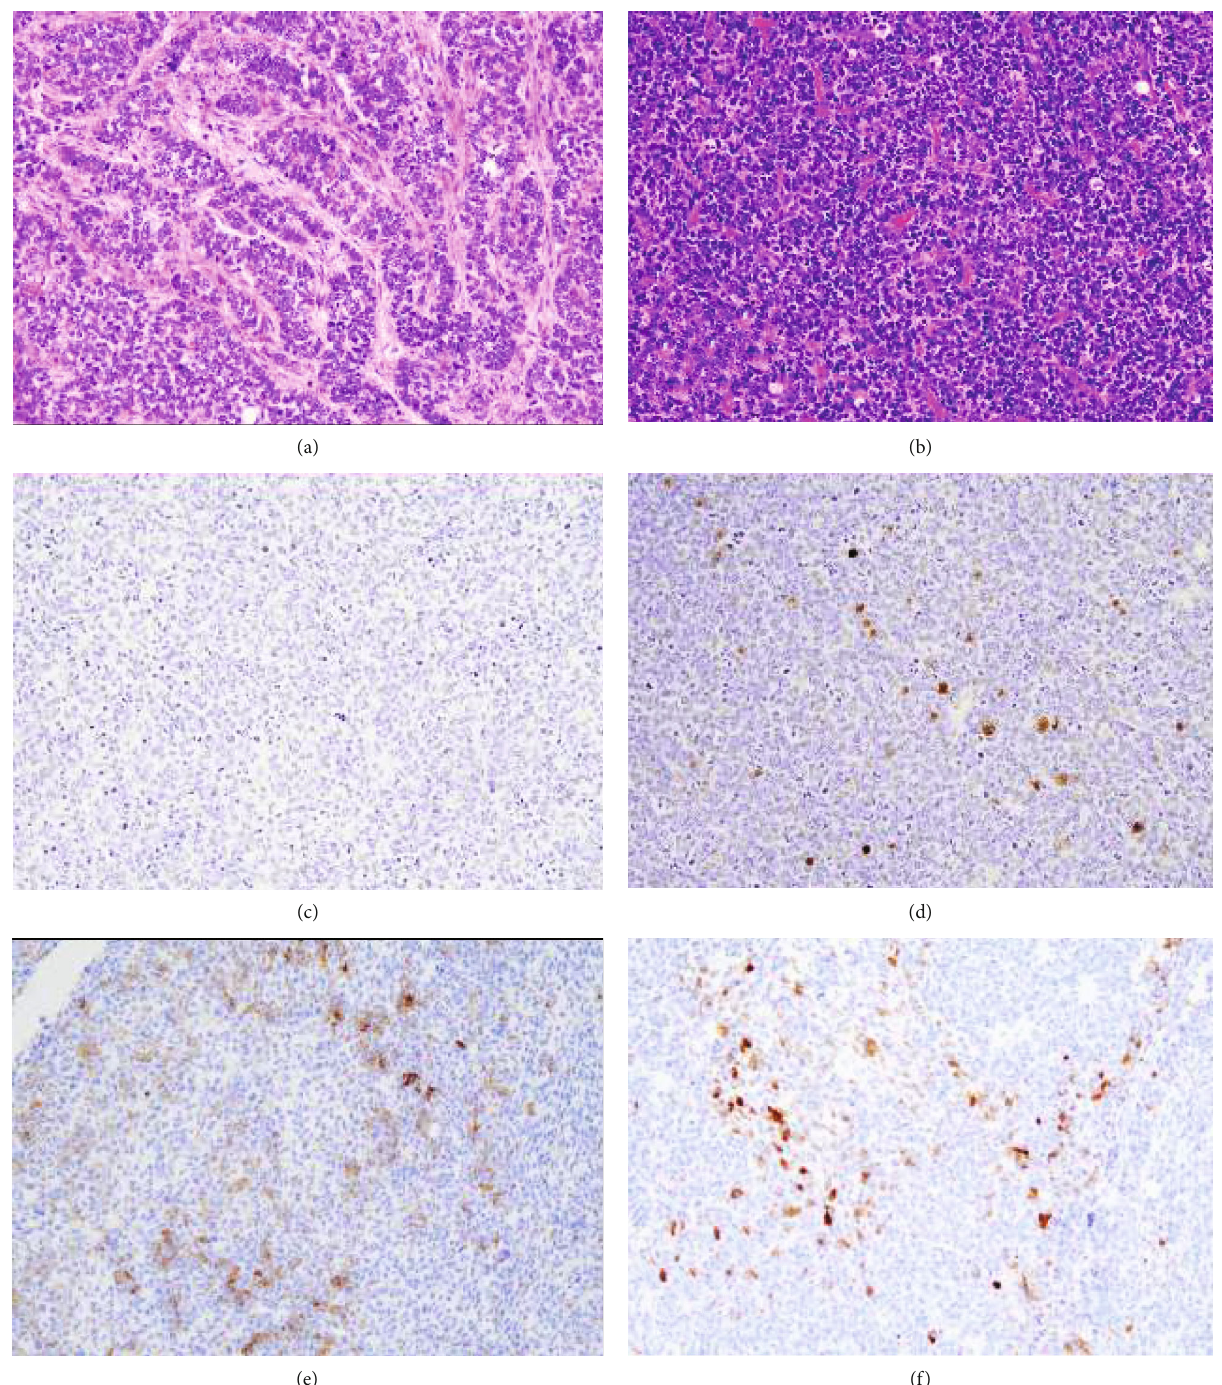
Figure 2: Histology image of the sertoliform endometrioid carcinoma component. (a) Sertoliform element in the glandular area. (b) Sertoliform element in the solid area. (c) AE1/AE3 was negative. (d) EMA staining was patchy. (e) α -inhibin showed positive staining. (f) Calretinin was also positive. (A, B: H&E staining, A, B: × 20, Immunostaining C-F: ×